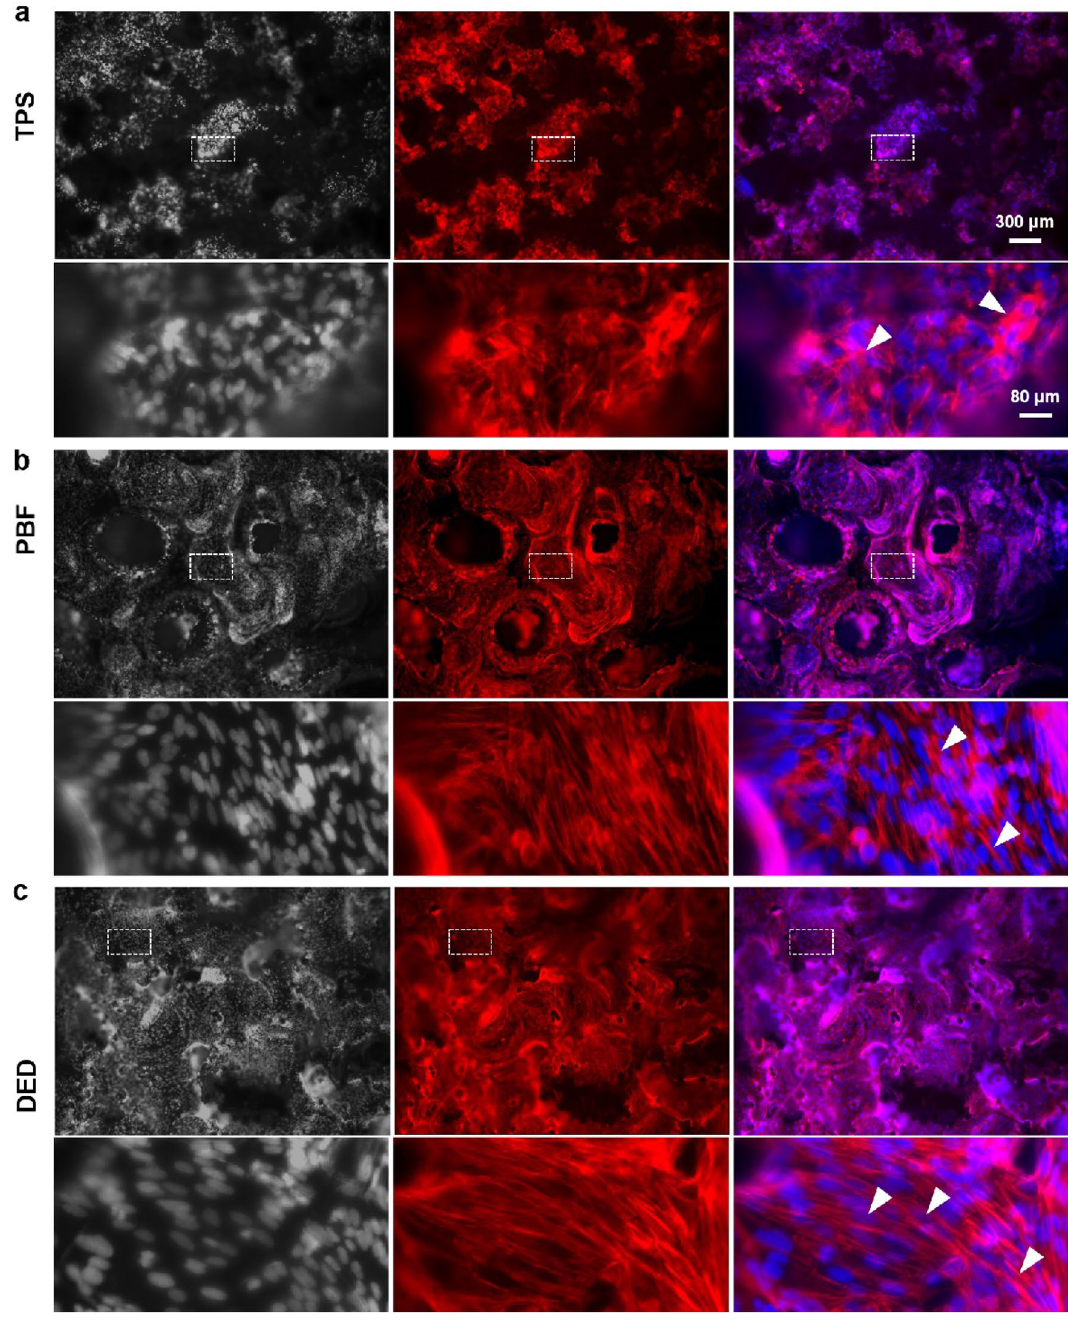
Figure 4. Immunofluorescence images of cells grown on ( a ) TPS, ( b ) PBF, and ( c ) DED surfaces. Nuclei are shown in gray (Hoechst 33324) and actin cytoskeletons in red (Rhodamin phalloidin). The nuclei are shown in blue in the merge channel. The cells were visualized using a wide-field fluorescence microscope (Leica TCS